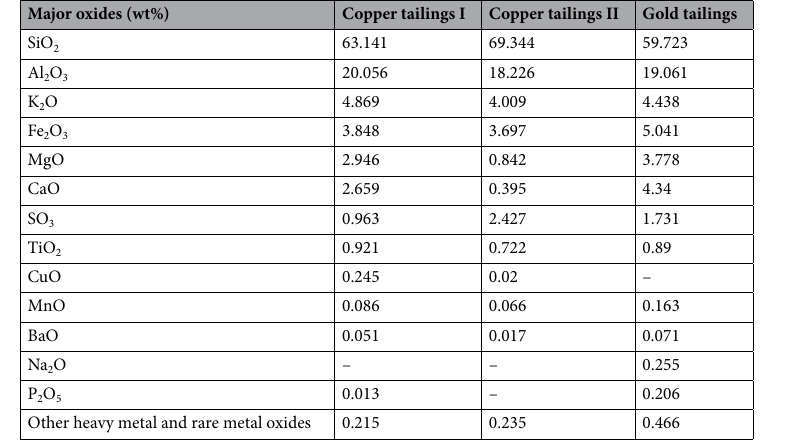
Table 2. Chemical composition of tailings materials tested.